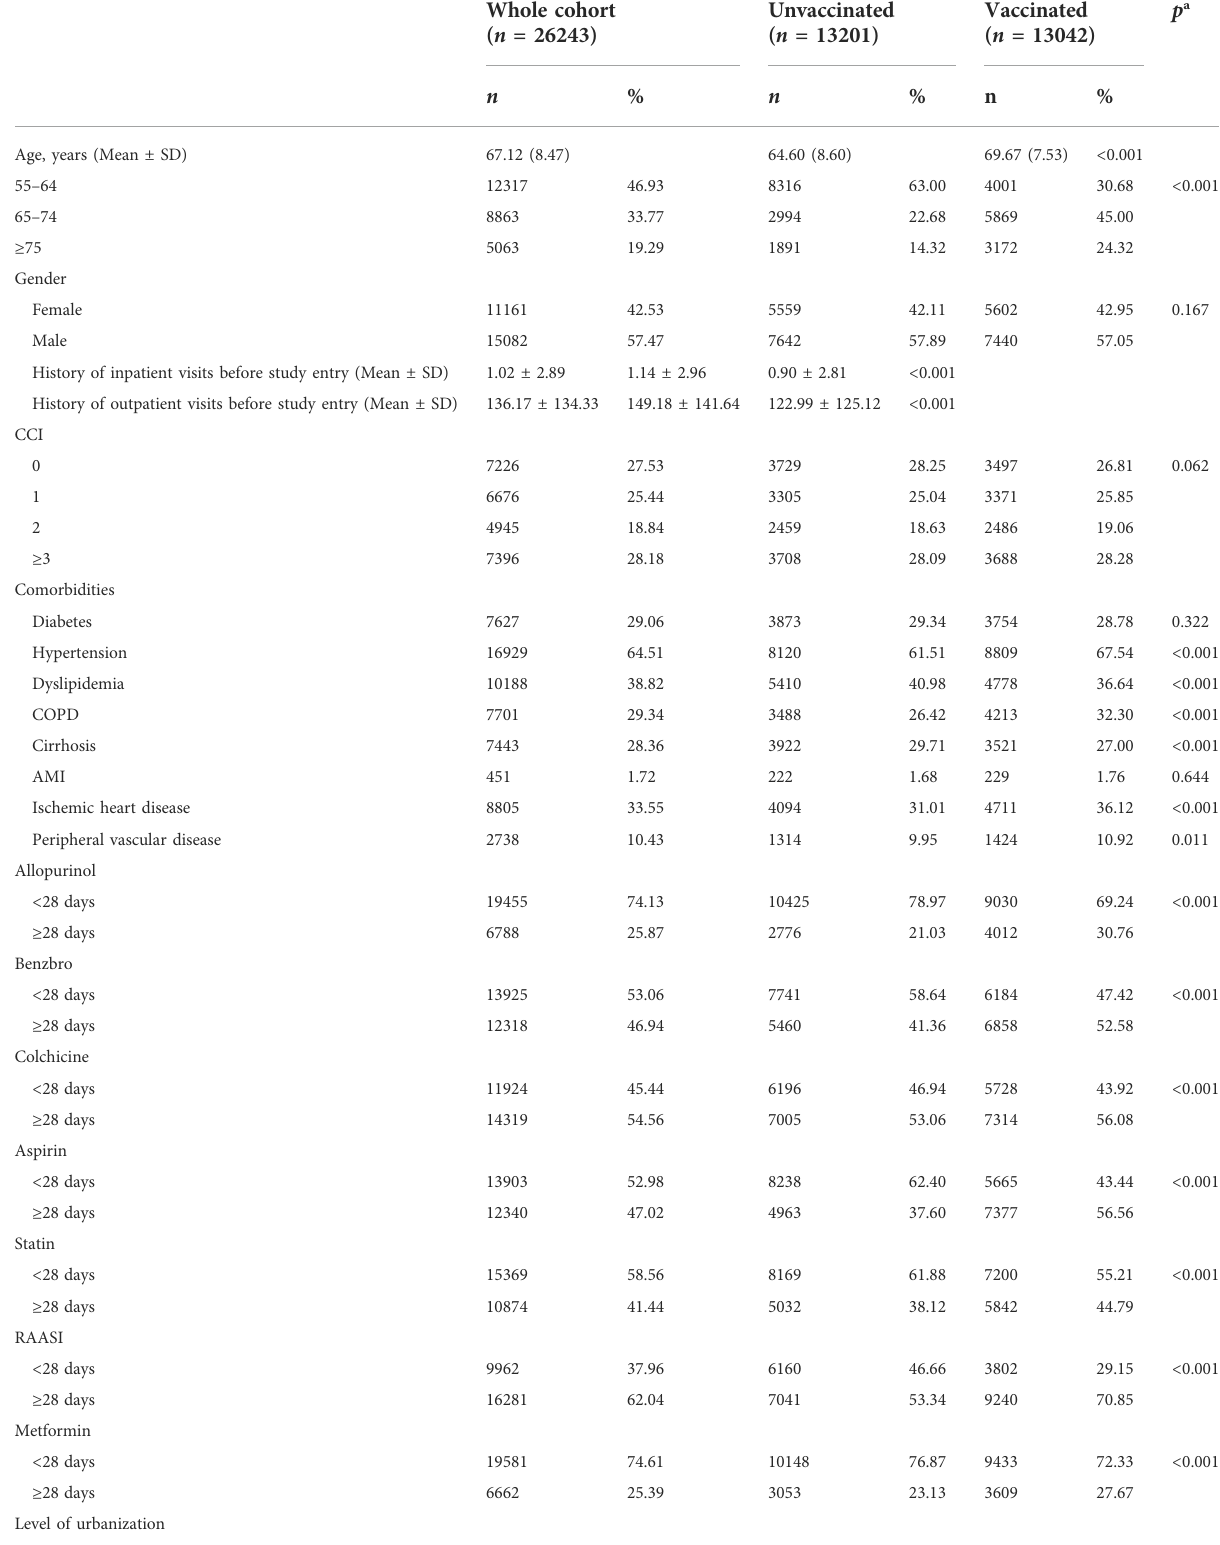
TABLE 1 Characteristic of the sample